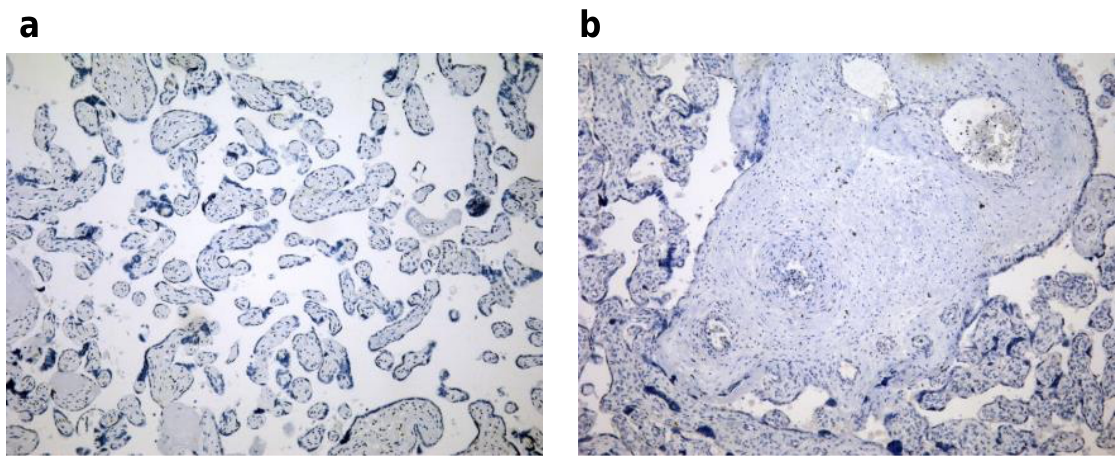
Figure 1. Sections of negative staining controls of placental tissue (magnification 100×), ( a ) HRP/DAB, ( b ) AEC/DAB kit. 2.5. Immunohistochemistry Scoring